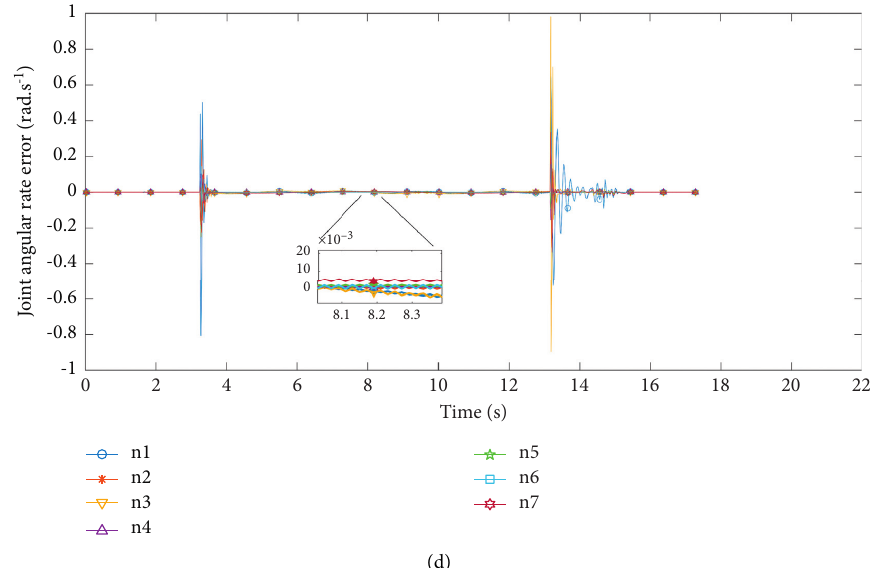
Figure 8: Comparison of control methods. (a) PD control error of joint angle. (b) PD control error of joint angular velocity. (c) Improved control joint angular error. (d) Improved control joint error angular